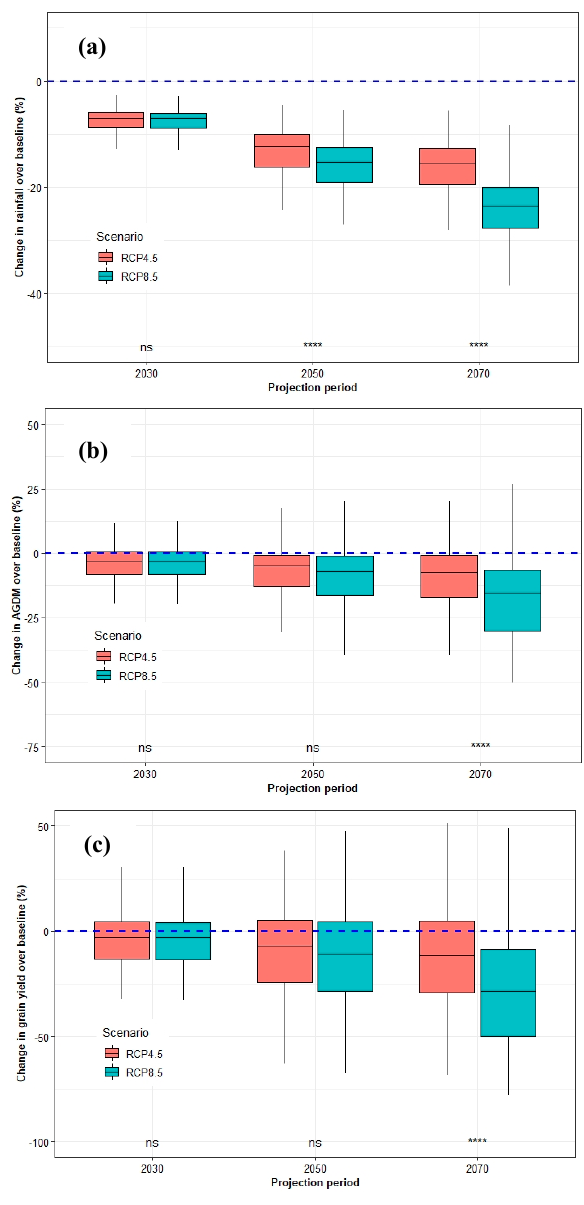
Figure 11. Effect of climate change on ( a ) rainfall, ( b ) above-ground dry matter, and ( c ) grain yield of wheat (cv. Wedgetail) for different emission scenarios and projection periods. ∗∗∗ significant at p < 0.001, ns = non-significant. RCP, representative concentration pathway.